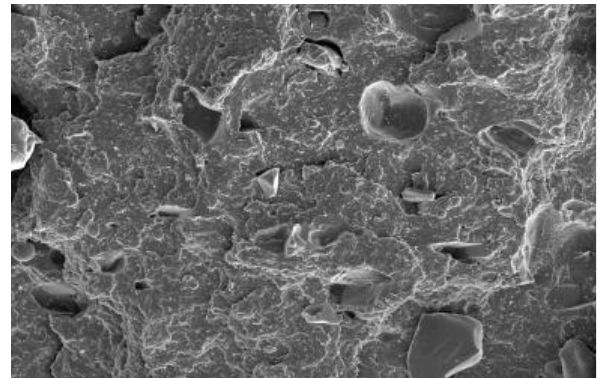
Figure 3. Scanning electron microscope photo of modified water-swellable rubber particles.